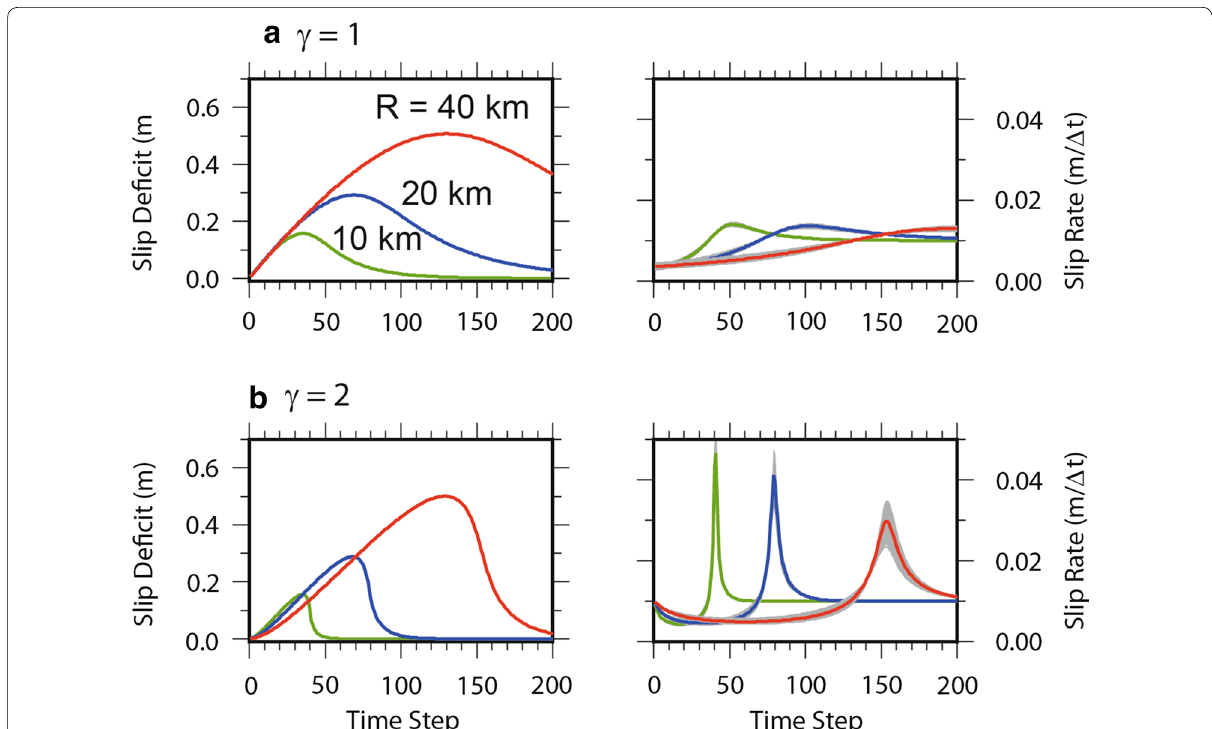
Fig. 3 Evolution of slip behavior in terms of slip deficit and slip rate, averaged for each patch ( center and right panels ), for a γ = 1 and b γ = 2 . The three lines correspond to R = 10 ( green ), 20 ( blue ), and 40 ( red ), respectively. In the right - hand panels , gray lines represent the behaviors of different parts of a patch, and the solid colored lines give the average behavior for an entire patch